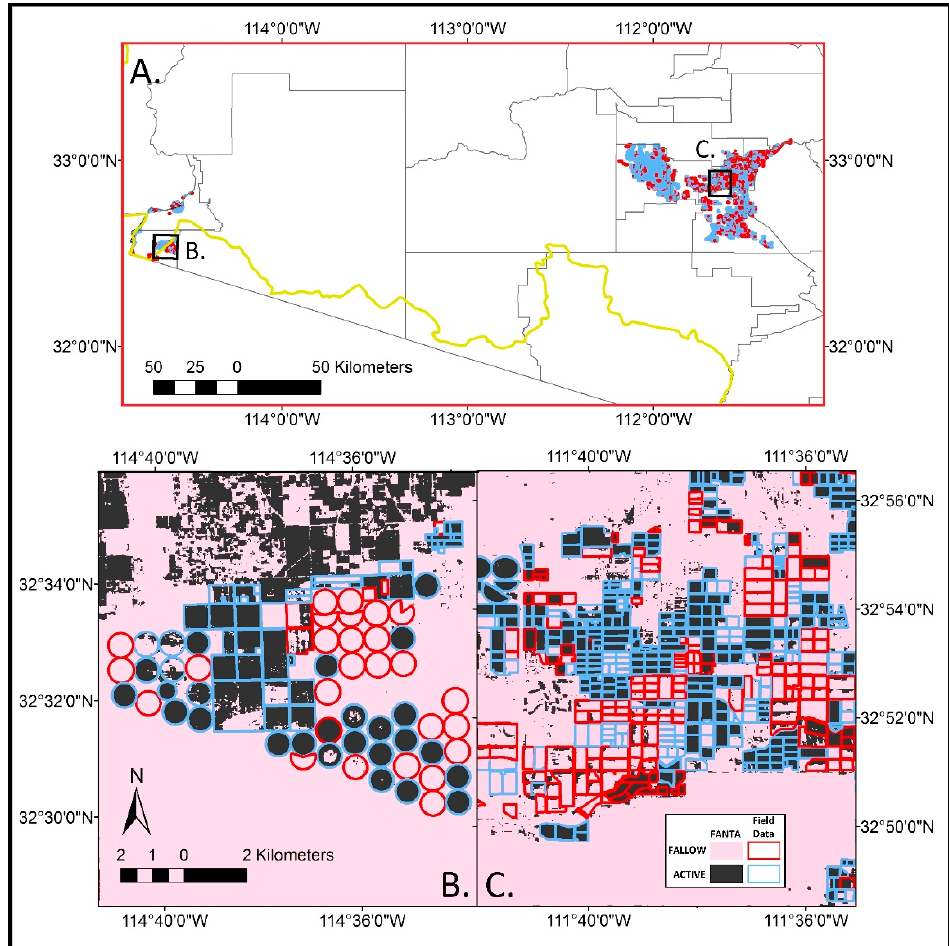
Figure 2. Classification of fallow and active cropland extent for all USGS in situ observations ( A ); an example region within LCRP in 2014 (overall accuracy: 88.9%) ( B ); and an example region within PPAMA in 2017 (overall accuracy: 87.2%) ( C ). In situ observations of fallow (red) and active (light blue) cropland areas are shown as vector outlines, whereas FANTA estimates of fallow (pink) and active (black) are shown on the base map.